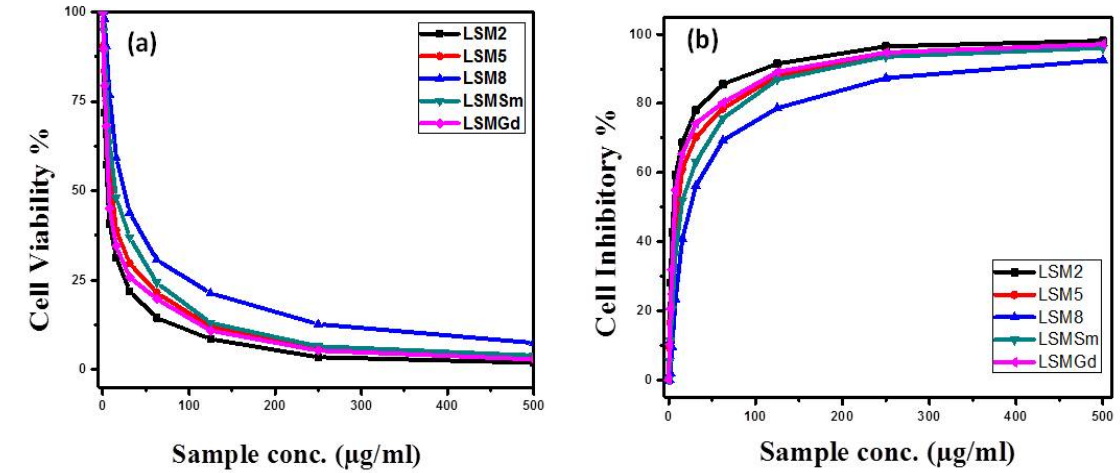
Figure 4. ( a ) The cell viability and ( b ) cell inhibitory (%) versus concentration of LSM with different Sr 2+ ion content and LSM with 0.1 Sm ions and 0.1 Gd ions at concentrations from 0 to 500 µg/m against CACO-2 cell line.